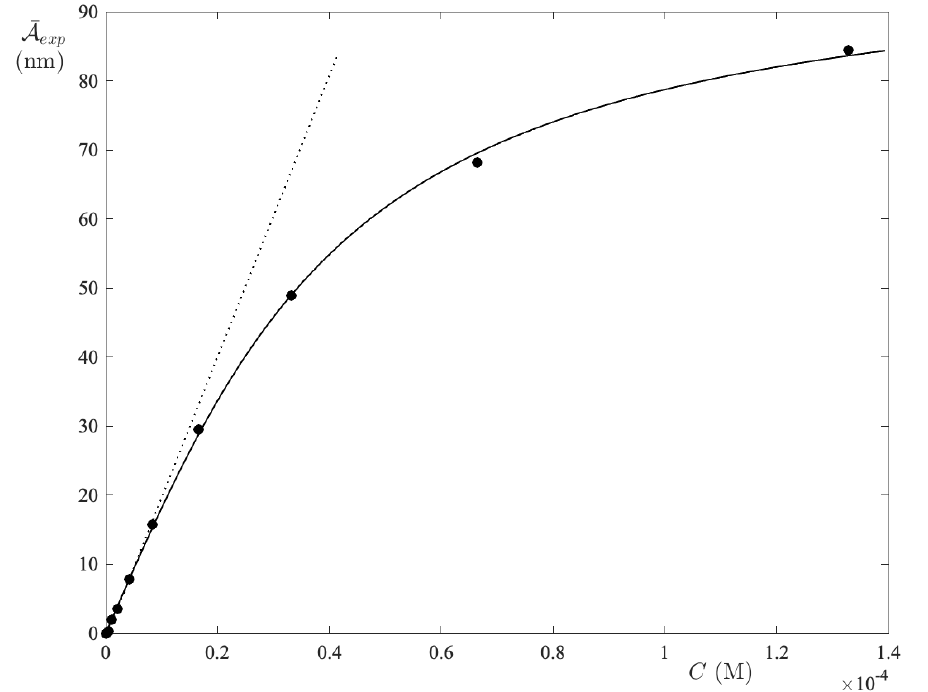
Figure 2. Integral absorbance vs. FS concentration in UPW. The limiting slope determines the absorption coefficient of the monomer form. The curve is a guide for the